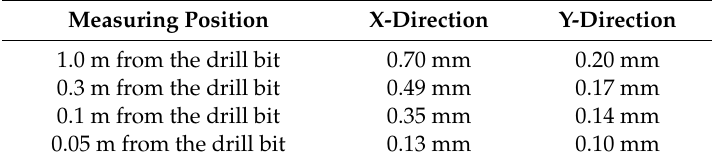
Table 6. Lateral displacement of BHA under di ff erent positions in numerical simulation.